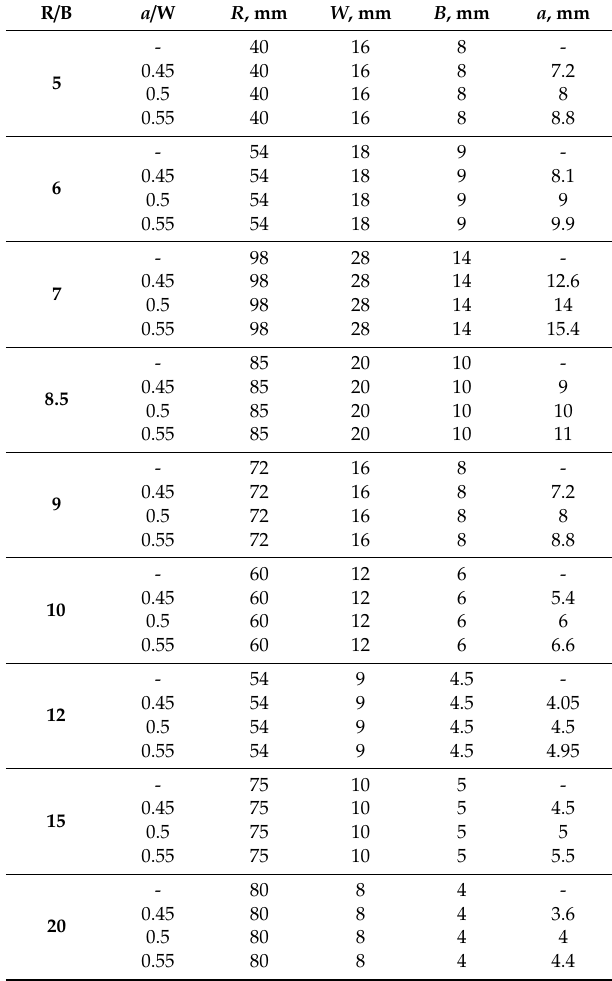
Table A1. The geometry configurations of the numerically modelled rings in the dependence by the ratio R / B between the outer radius and the wall thickness and crack depth a / W